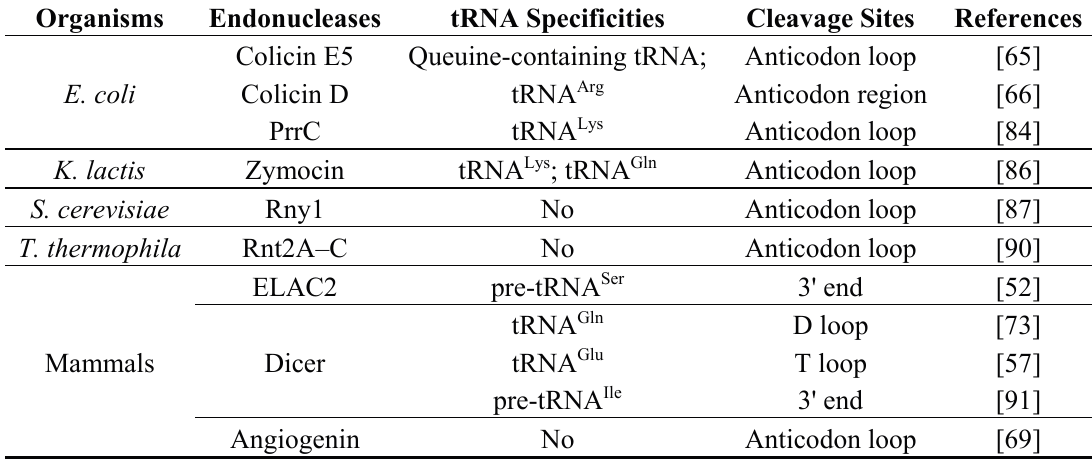
Table 2. List of endonucleases capable of cleaving tRNAs or pre-tRNAs.